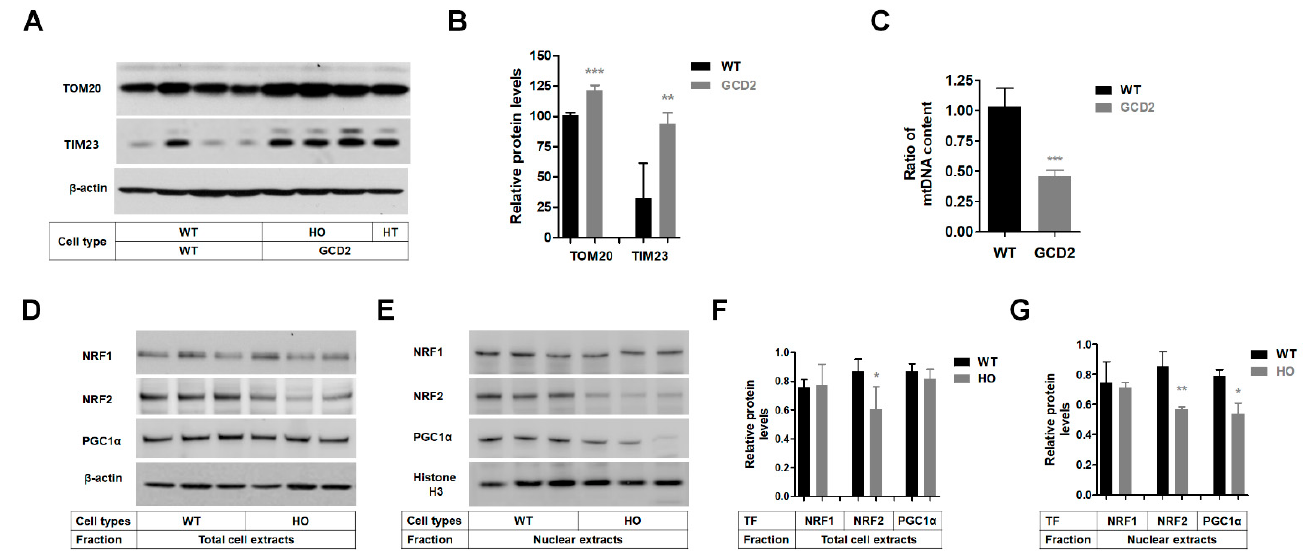
Figure 6. Mitochondrial biogenesis reduced in GCD2 corneal fibroblasts. ( A ) The levels of TOM20 and TIM23 were analyzed in WT and GCD2 HO corneal fibroblasts by Western blotting. β‐ actin was used as the loading control. Blots are representative of three independent experiments. ( B ) The quantification of TOM20 and TIM23 levels in WT and GCD2 HO corneal fibroblasts from three independent experiments ± SD. ( C ) Quantitative PCR Analysis of mtDNA content in WT and GCD2 corneal fibroblasts. mtDNA levels were significantly lower in GCD2 compared to WT corneal fibroblasts. The data are presented as mean ± SD from three independent experiments. ( D ) The levels of PGC ‐ 1 α , NRF1, and NRF2 in WT and GCD2 HO corneal fibroblasts were determined by Western blotting in total extracts ( D ) and in nuclear fraction ( E ) of WT and GCD2 HO corneal fibroblasts. The quantification of PGC ‐ 1 α , NRF1, and NRF2 protein bands in in total extracts ( F ) and in nuclear fraction ( G ) of WT and GCD2 HO corneal fibroblasts from three independent experiments. Histone H3 was used as an internal loading control. Data are presented as mean ± SD, n = 3 per group. ( n = 3). * p < 0.05, ** p < 0.01, *** p < 0.001.